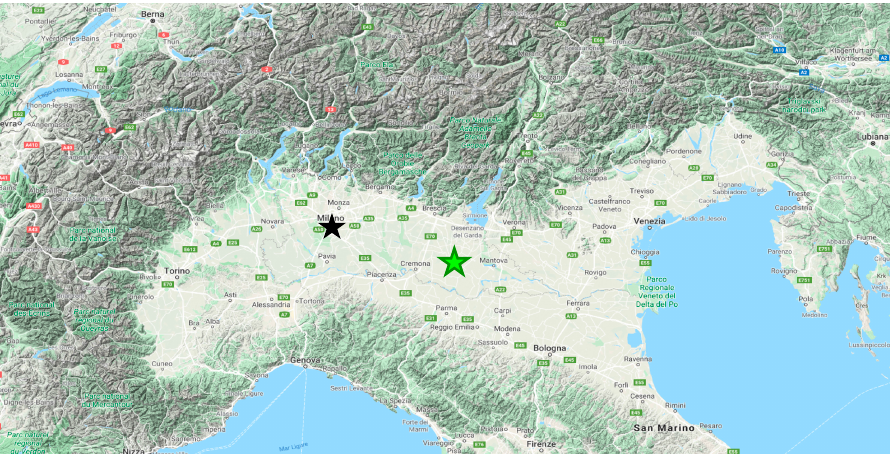
Figure 1. Location of the Milano Torre Sarca (MI-TS, black star) and Oasi Le Bine (OB, green star) sampling sites.